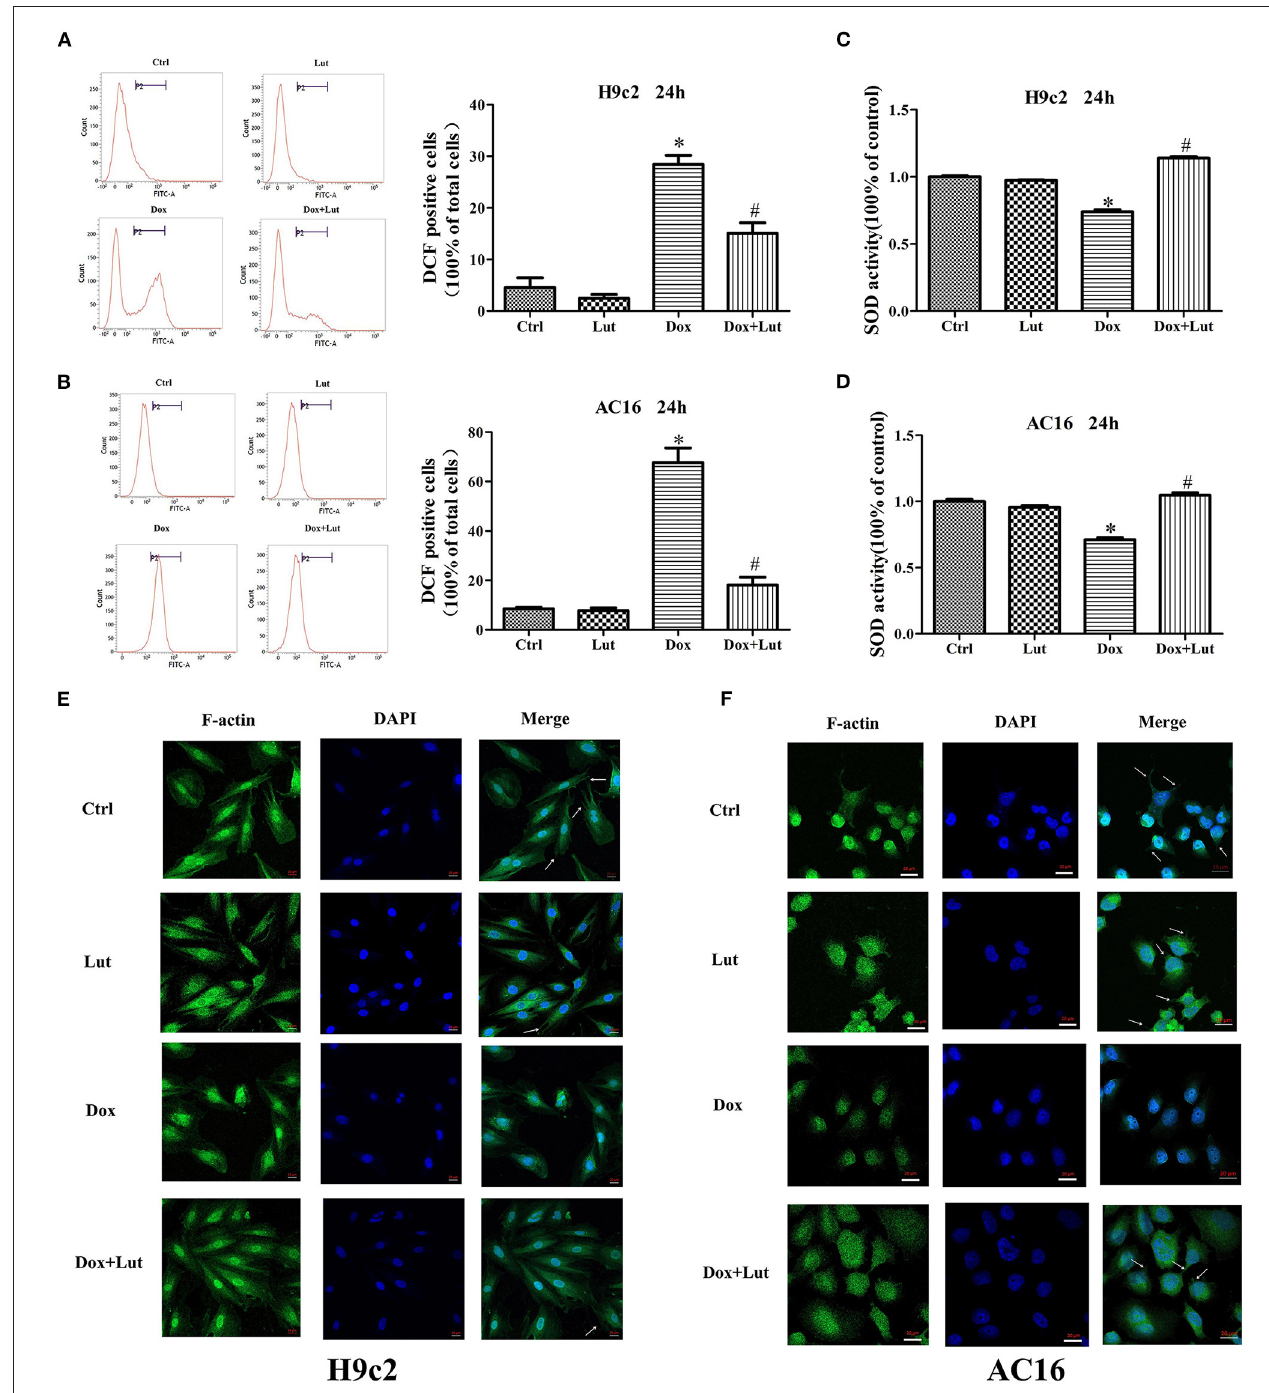
FIGURE 2 | Effect of Lut treatment on Dox-induced oxidative stress and cytoskeletal damages in H9c2 and AC16 cells. (A,B) ROS and (C,D) SOD levels in H9c2 and AC16 cells after Dox and Lut treatment. (E,F) Cytoskeleton staining in H9c2 and AC16 cells after Dox and Lut treatment (630 × ). White arrows show microfilaments and microtubules. Mean ± SD, n = 3 independent experiment. * P < 0.05 compared with control group. # P < 0.05 compared with Dox group.